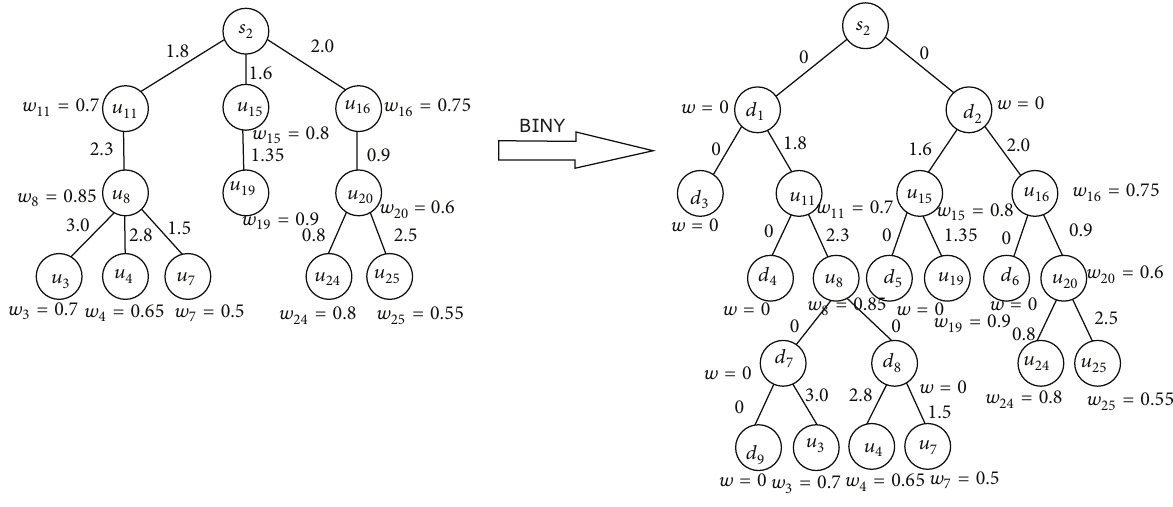
Figure 3: Illustration for 𝑇(𝑠 2 ) and 𝑏(𝑇(𝑠 2 )) .